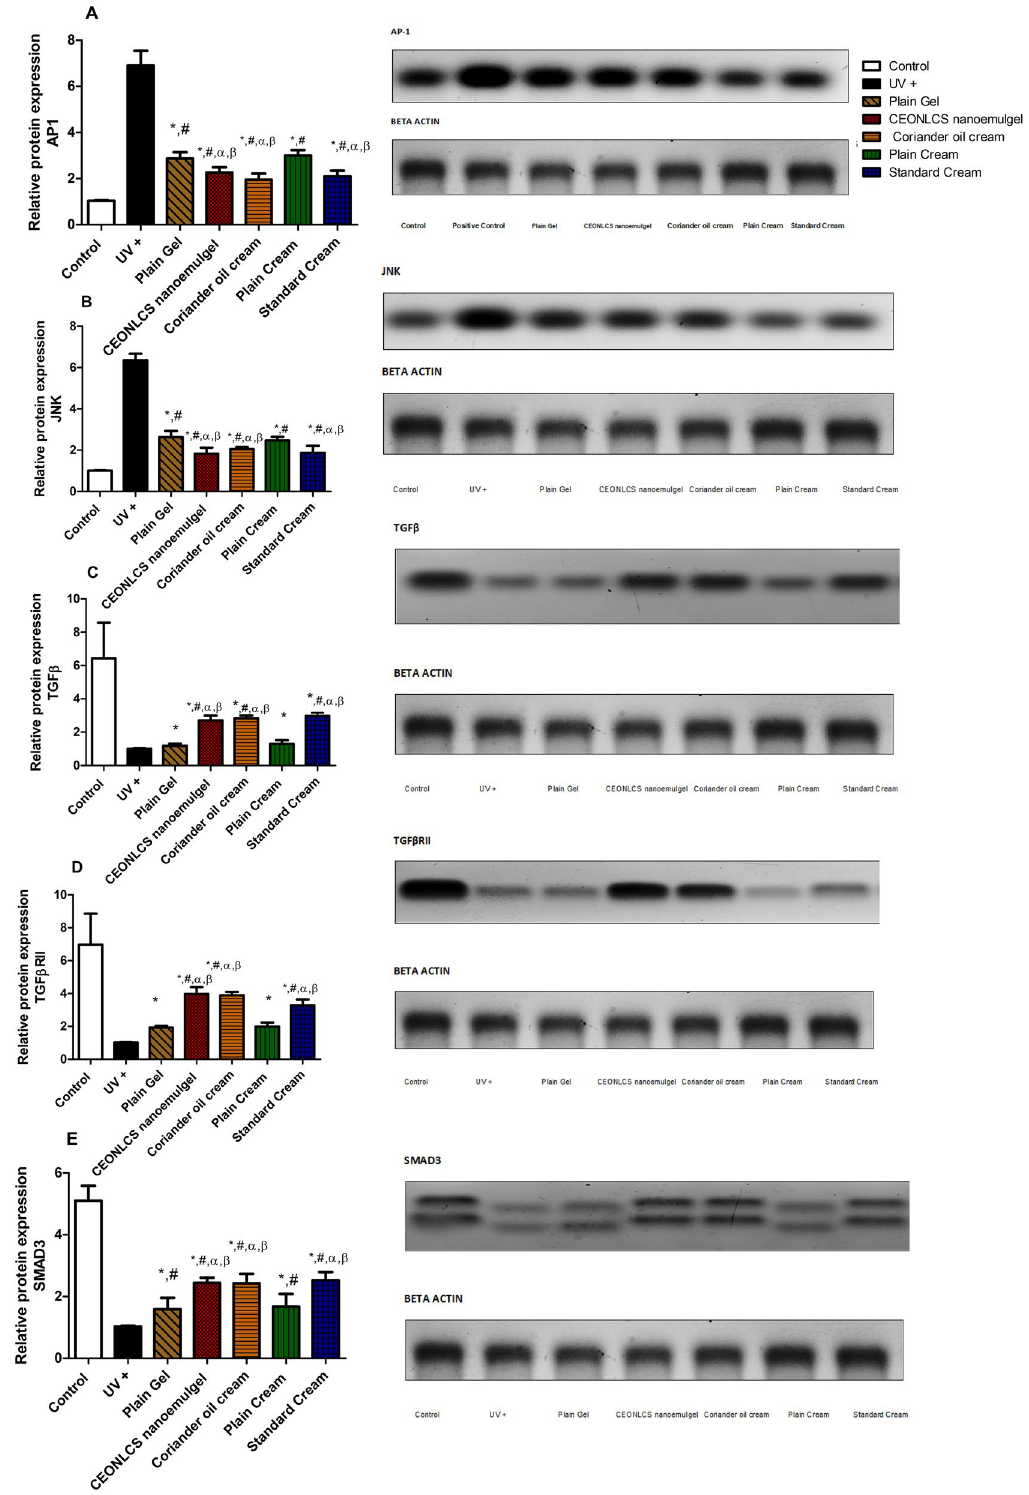
Figure 4. Effect of plain cream, plain gel, Coriander oil cream formula, CEONLC nanoemulgel formulation, and standard cream treatment on protein expression of ( A ) AP-1, ( B ) JNK, ( C ) TGF β , ( D ) TGF β RII, and ( E ) SMAD3 in skin homogenates of photoaged mice. Each result represents the mean value for 8 mice ± SD of the mean. Statistical analysis was carried out by one-way ANOVA followed by Tukey’s multiple comparison test. *Statistically significant from the normal control group at p ≤ 0.05, # statistically significant from the UV injured group at p ≤ 0.05, α statistically significant from the plain cream base group at p ≤ 0.05, and β statistically significant from the plain gel base group at p ≤